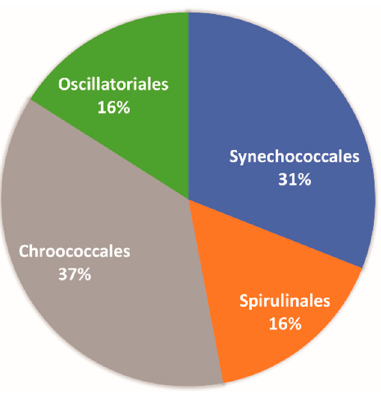
Figure 5. Pie diagrams presenting the percentage of each Cyanobacteria order.